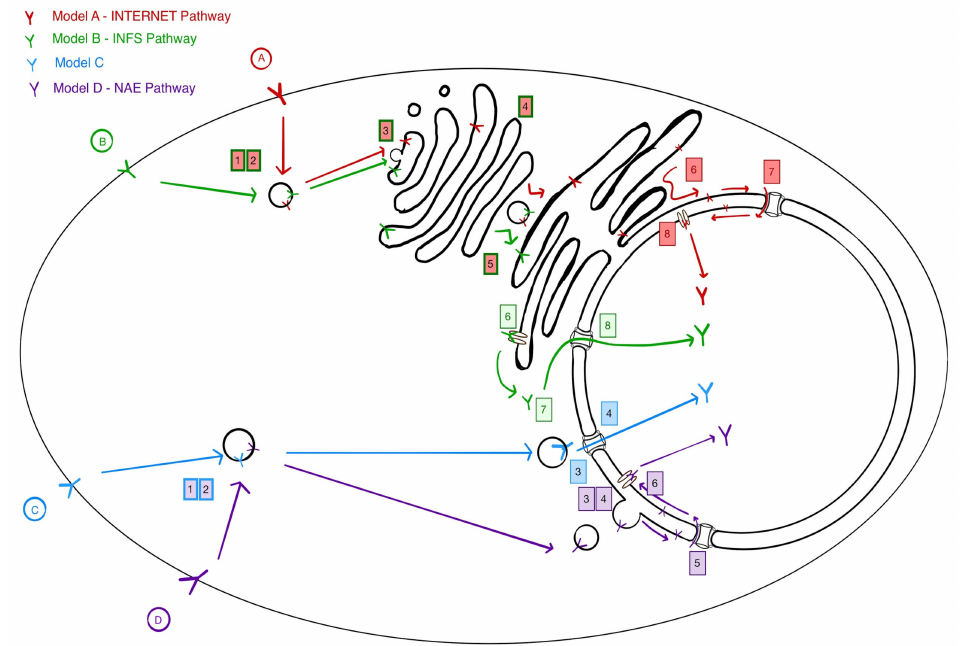
Figure 1. The current models to explain the nuclear translocation mechanism for cell surface receptors. The di ff erent steps required are numbered, 1: Endocytosis and 2: Sorting into the proper endosomal pathway are common to all models. Models A and B: Step 3: Targeting and fusion of endosomal carriers to Golgi membranes, 4: Retrograde Golgi tra ffi c across the Golgi, 5: Transport from the Golgi to the ER. Model A: 6; di ff usion of receptor to the outer nuclear membrane (ONM), 7: Transport across the Nuclear Pore Complex (NPC) to the inner nuclear membrane (INM), 8: Extraction to the nucleoplasm via an INM embedded channel. Model B: Step 6: Extraction to the cytosol via an ER embedded channel, 7: Binding to nuclear targeting factors, 8: Transport across the NPC. Model C: Step 3: Targeting to the nuclear envelope and interaction with the NPC, 4: Translocation and extraction across the NPC into the nucleoplasm. Model D: Step 3: Targeting and docking to the nuclear envelope, 4: Fusion of membranes and transfer of material to the outer nuclear membrane, 5: Transport across the NPC, 6: Extraction